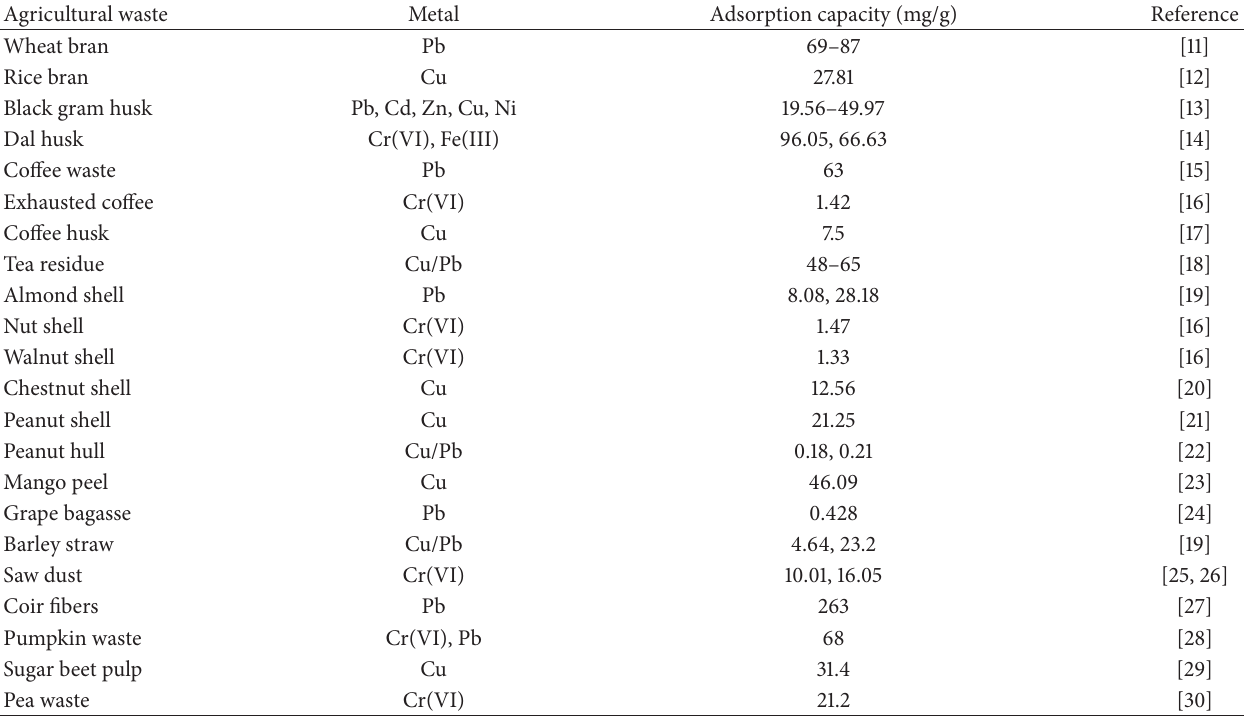
Table 1: Comparison of adsorption capacity of various agricultural